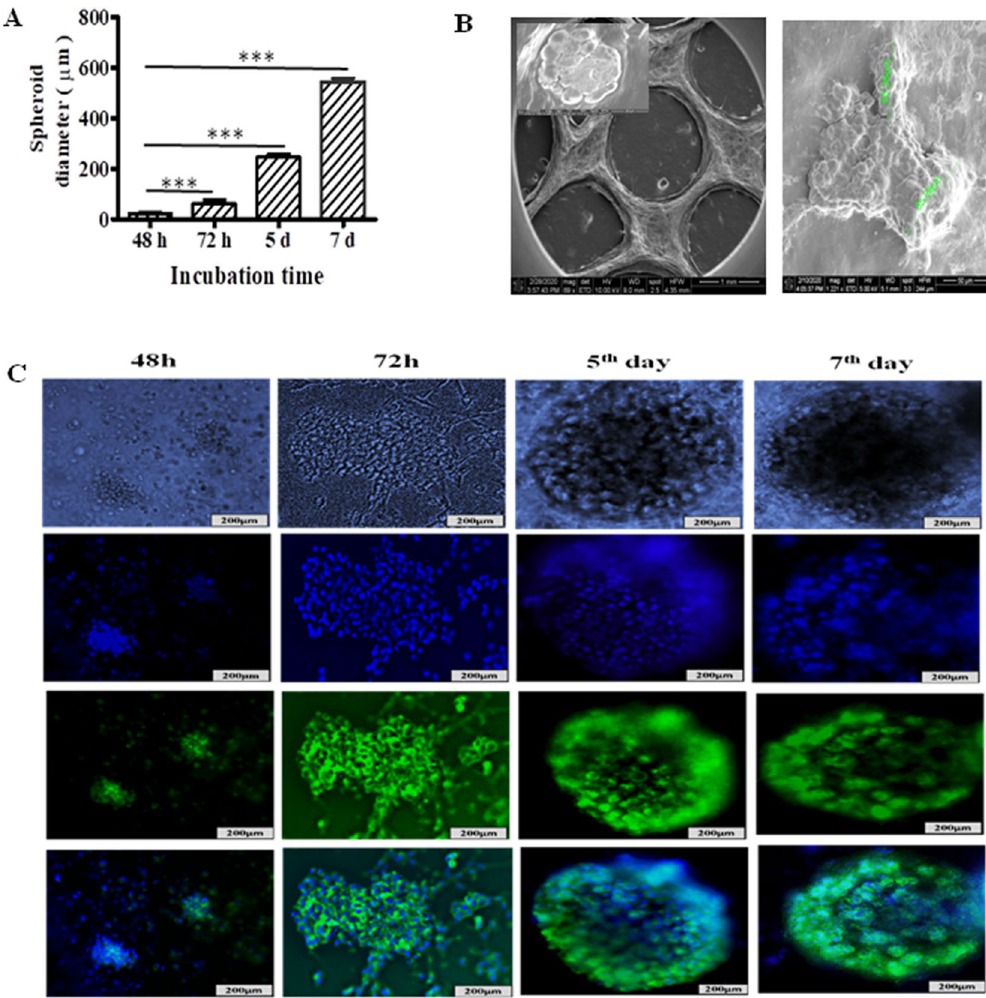
Figure 7. 3D printed NSCLC-PDX cells/spheroids growth in printed ink H4-RGD scaffolds. ( A ) Average spheroid proliferation/growth rate over a period of 7 days. ( B ) SEM images of spheroids inside the ink H4RGD scaffold. ( C ) Spheroid images captured in bright field microscopy and also after staining with NucBlue/Actin Green staining after 48 h, 72 h, on 5th day and 7th day. Microscopic images were acquired by using Olympus Microscope IX71 and cellSens Standard software (version 1.16; Tokyo,